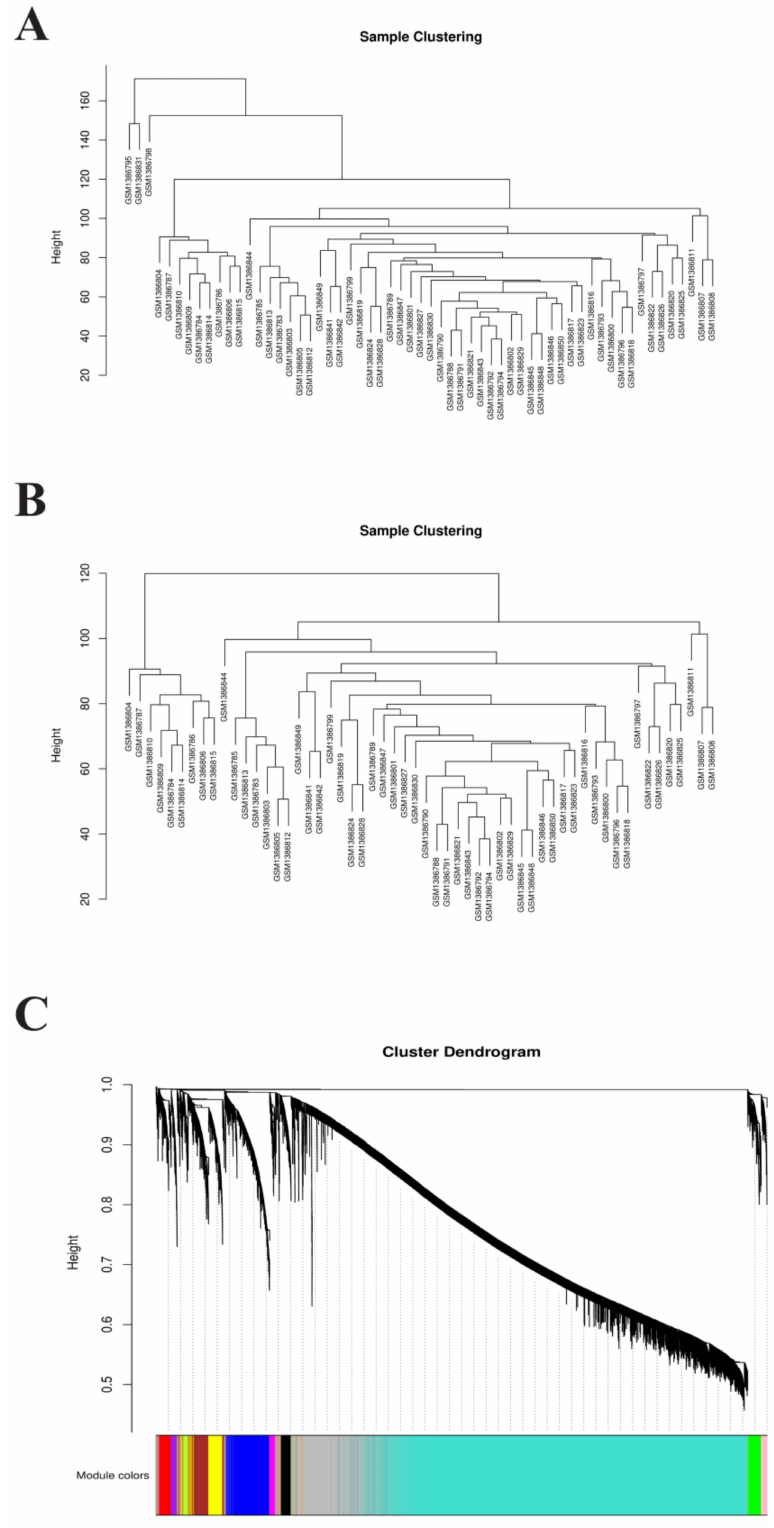
Figure 3. Soft-setting of threshold power. ( A , B ) GSM1386795, GSM1386831, and GSM1386798 were excluded as outliers. ( C ) The minimum number of genes per module was set to 30 according to the criteria of the dynamic tree-cutting algorithm. Thirteen modules were generated. Genes are grouped into modules by hierarchical clustering, with different colors representing different modules, where the grey default is for genes that cannot be grouped into any